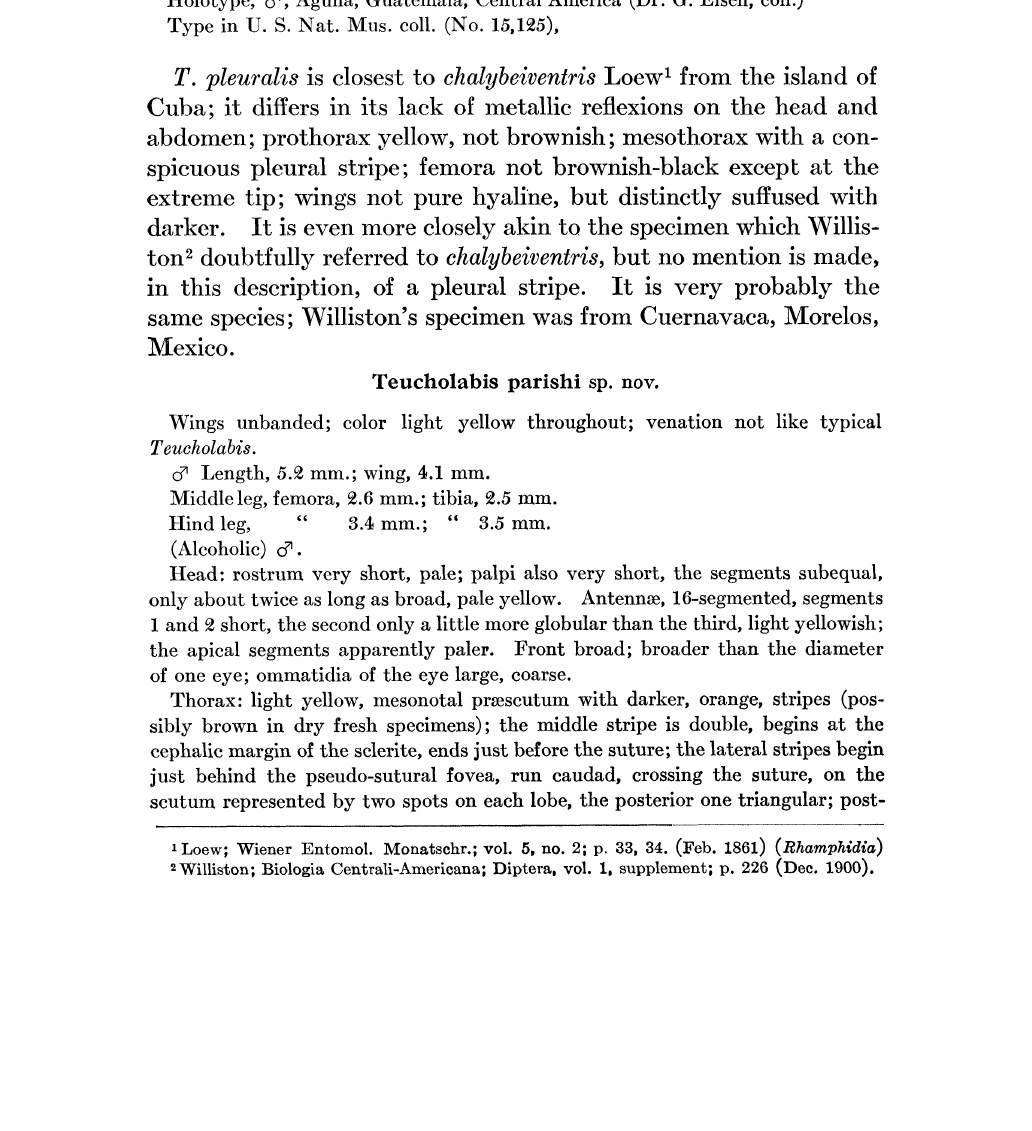
Psyche [February abdomen. Halteres dark brown. Legs: coxe and trochanters light yellow; femora light yellow, the apicc broadly dark brown; tibia and tarsi brownish-black. Wings, subhyaline, with a distinct dusky tinge; stigma round, brown, its posterior margin not touching R2+3. Venation" Sc rather long, that portion beyond the origin of Rs slightly longer than cell 1st M.(discal); cross-vein r close to the tip of R.i; space on R2+3 before r, as long as the basal deflection of Cul; cell 1st M2 very elongated, narrowed anteriorly; outer deflection of M3 longer than cross-vein m (these two components making up the distal end of cell 1st Ms); basal deflection of Cul slightly beyond the fork of